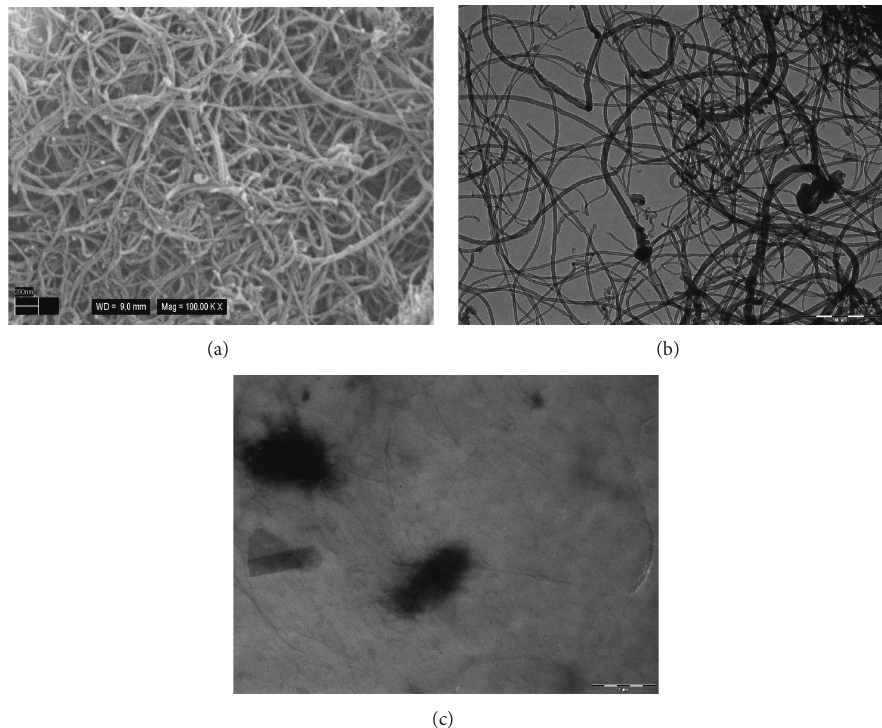
Figure 2: SEM micrographs of r-MWCNTs ((a) scalebar 200 nm), t-MWCNTs in SDS solution ((b) scalebar 500 nm), TEM micrograph of t-MWCNTs in PVA solution ((c) scalebar 1 𝜇